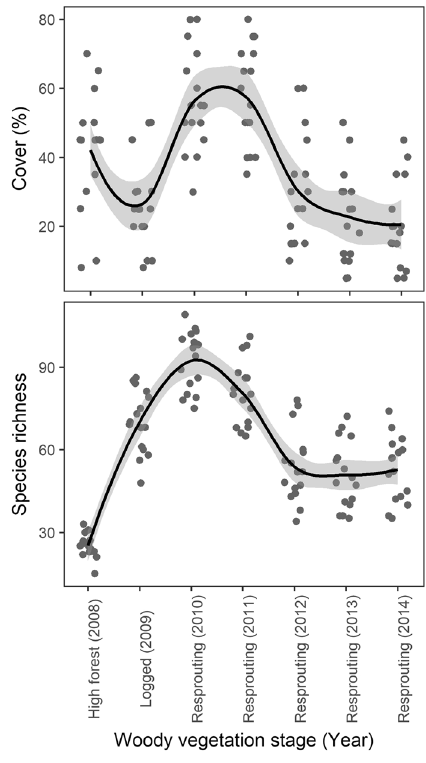
Figure 1. Temporal development of species richness and cover of the herbaceous layer from the vegetation season before logging (2009) to the 6th vegetation season after logging (2014). Solid line with the grey band represents the LOESS fitted model with 95% confidence intervals.